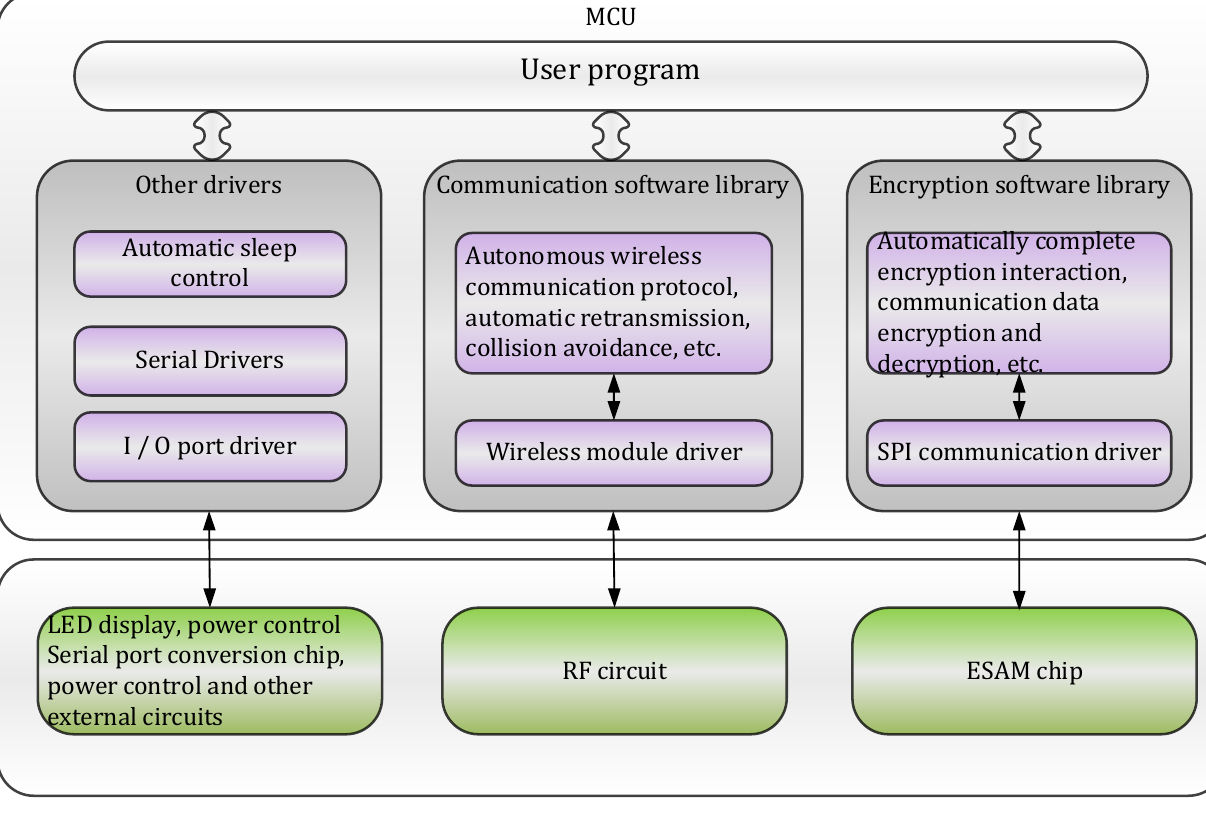
Figure 1. Architecture diagram of intelligent drop fuse